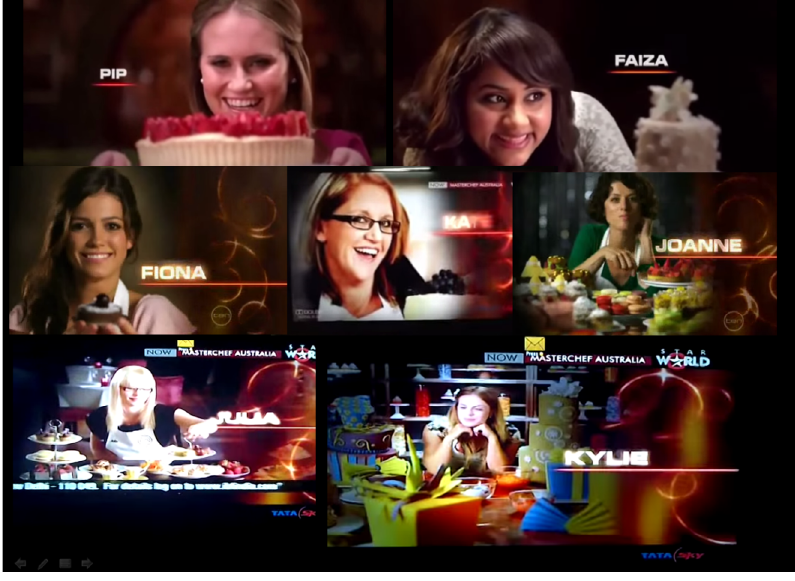
Figure 1. Female contestants pictured with desserts in their introduction